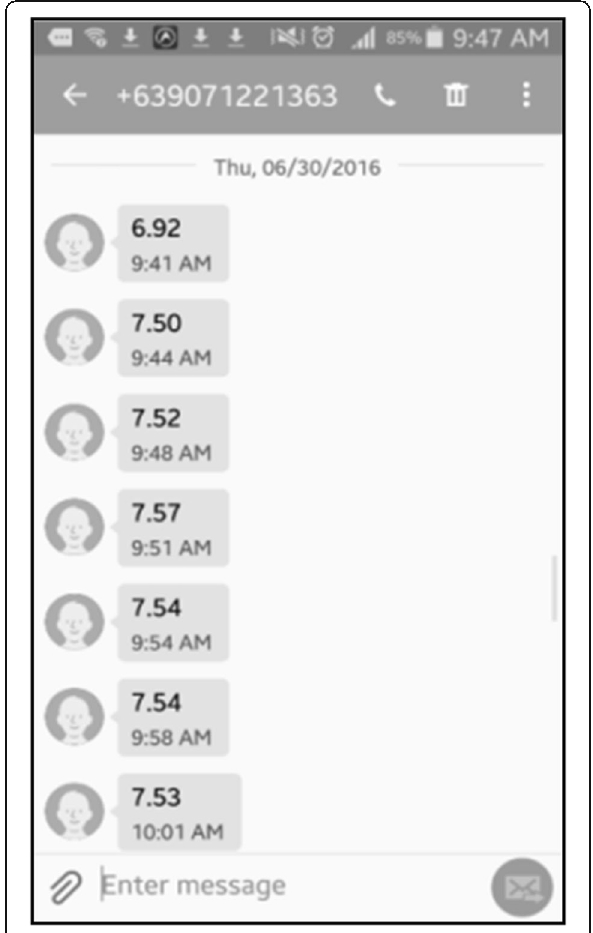
Fig. 5 The Sample SMS pH